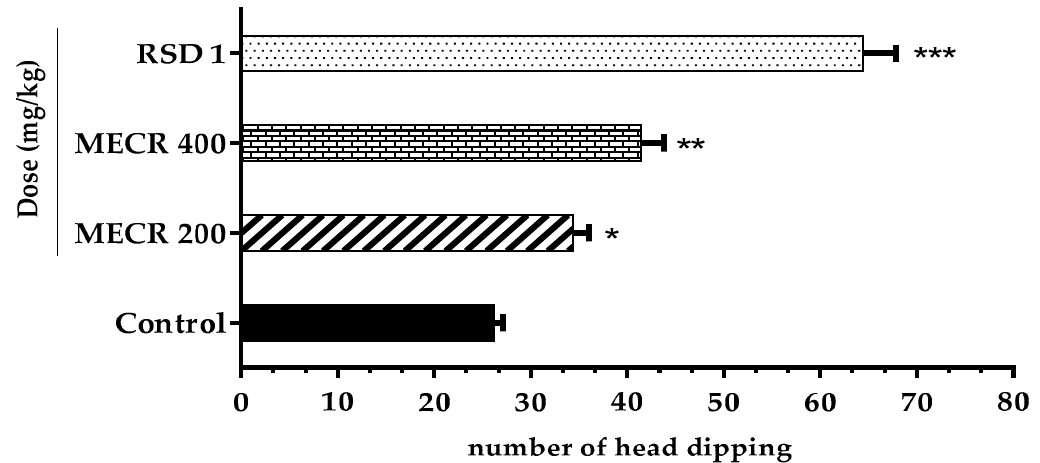
Figure 2. The effect of methanol extract of Cuscuta reflexa (MECR) in hole board test in mice. Values are expressed in mean ± SEM (n = 6). *p < 0.05, **p < 0.01 and ***p < 0.001 compared to control (Dunnett’s test). RSD: reference standard drug (Diazepam, 1 mg/kg).